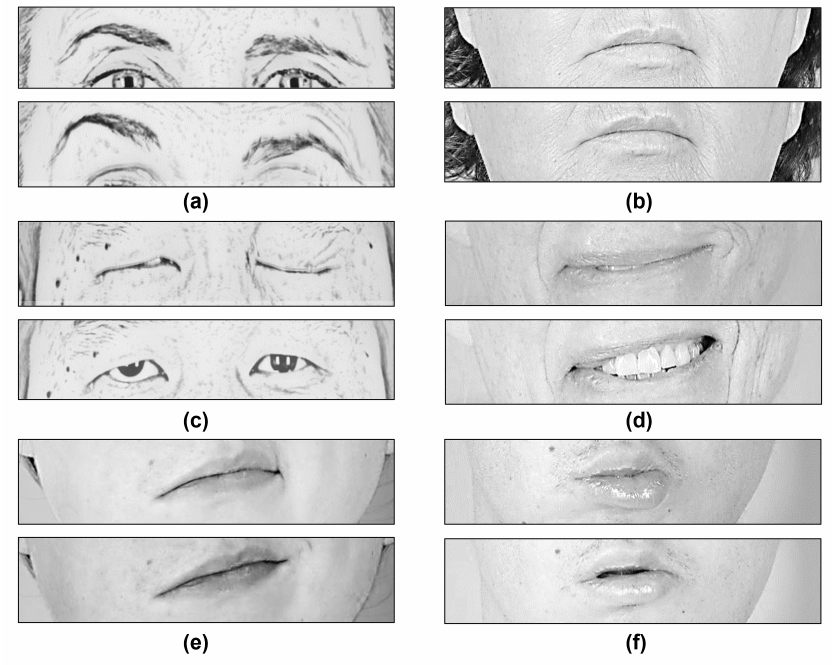
Figure 7. Analysis of facial gestures in patients suffering from facial palsy: ( a ) Small change in the eyebrows’ height. ( b ) Similar mouth shape (width and height). ( c ) Slightly different change in the eyes’ height. ( d ) Similar change in the mouth shape. ( e ) Activated lip corner puller. ( f ) Similar change in the mouth